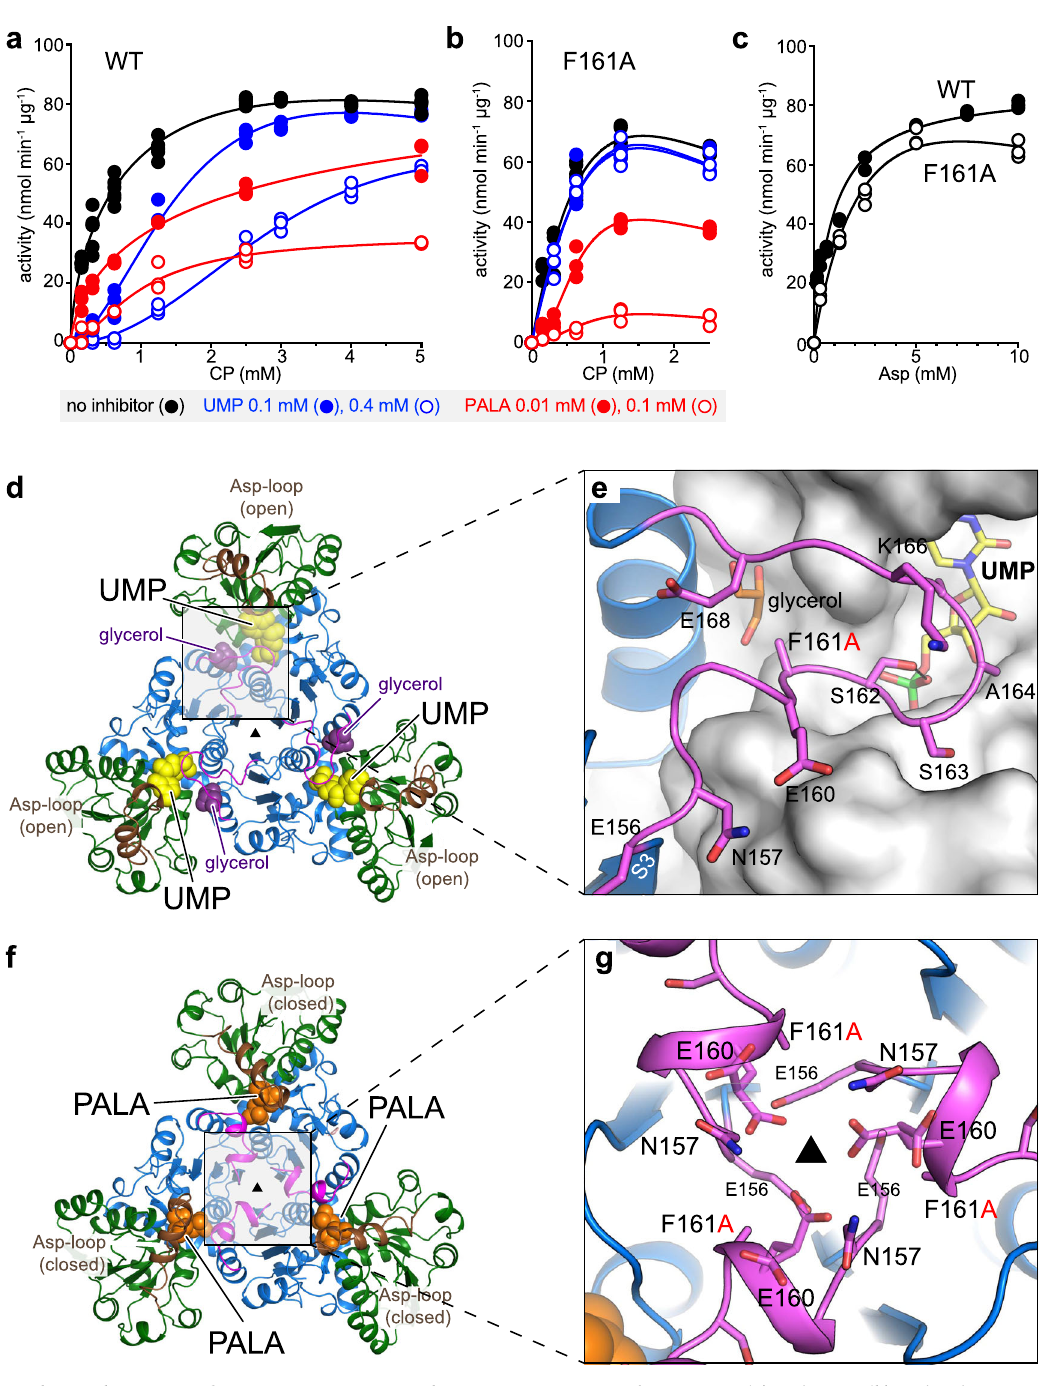
Fig. 5 Activity and crystal structure of atATC mutant F161A. a , b CP saturation curves of atATC WT ( a ) and F161A ( b ) in the absence and presence of UMP or PALA. c Asp saturation curves for WT and F161A. Equations to fi t the kinetic data are detailed in Methods. d , e Crystal structure of atATC-F161A trimer complexed with UMP ( d ), and detail of the interactions of the CP-loop ( e ), showing a glycerol molecule replacing the missing F161 side chain. f , g Crystal structure of F161A with PALA bound to the three active sites ( f ), and detail of the interactions around the molecular axis ( g